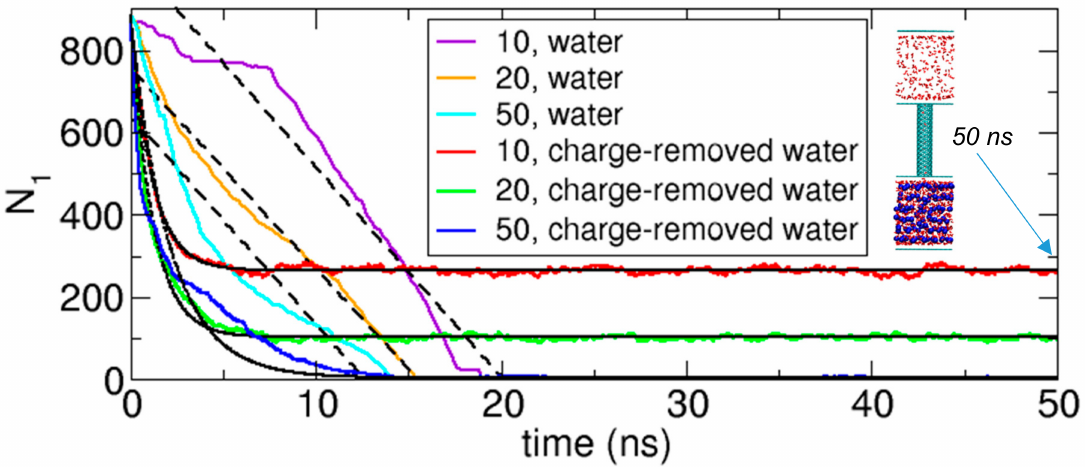
Figure 12. Comparison of the transport of water molecules with the transport of charge-removed water molecules [1] in terms of the numbers of molecules in Compartment 1 ( N 1 ) as functions of time for the cases of N O = 125 and IS WO = 10, 20, and 50. The black lines represent the linear fitting for the transport of water molecules and the exponential fitting for the transport of charge-removed water molecules. The inset figure shows the equilibrium state at 50 ns for the charge-removed water case of N O = 125 and IS WO =